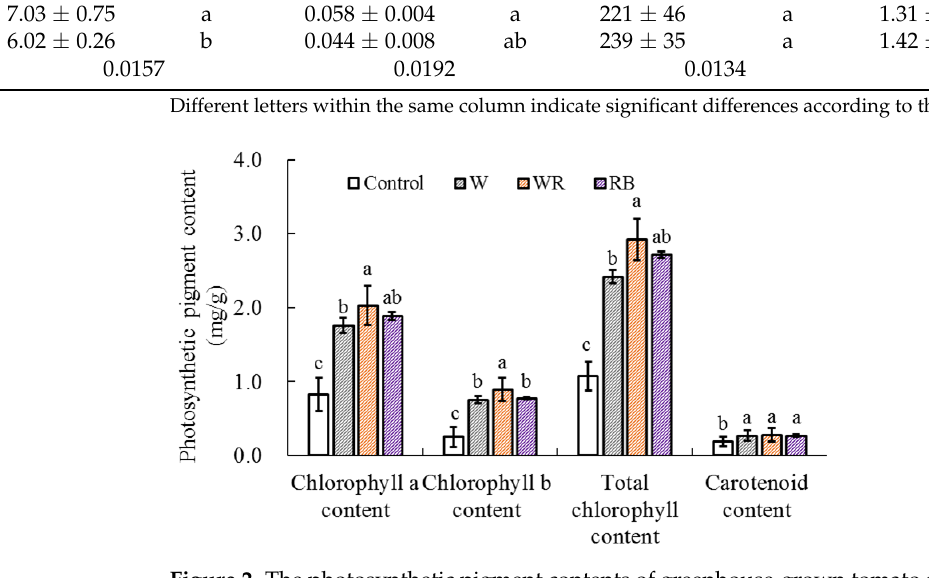
Figure 2. The photosynthetic pigment contents of greenhouse-grown tomato seedlings grown under supplementary white LEDs, white plus red LEDs, and red plus blue LEDs, respectively, and tomato seedlings cultivated under sunlight only were regarded as the control. Different letters on top of bars denote significant differences according to the LSD test ( p < 0.05). Error bars represent the mean ± SD.